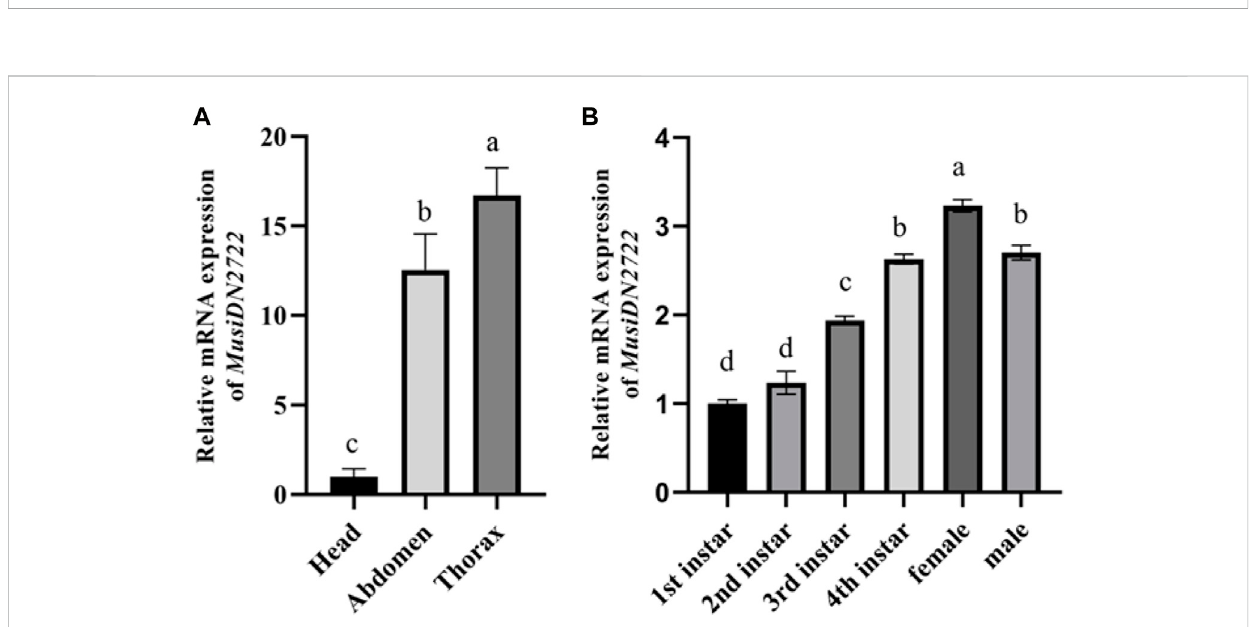
FIGURE 6 Relative levels of expression of MusiDN2722 (A) in different adult tissues and (B) at different developmental stages of M. usitatus . Data are represented in the form mean ± SEM. Different letters indicate a signi fi cant difference at p < 0.05.